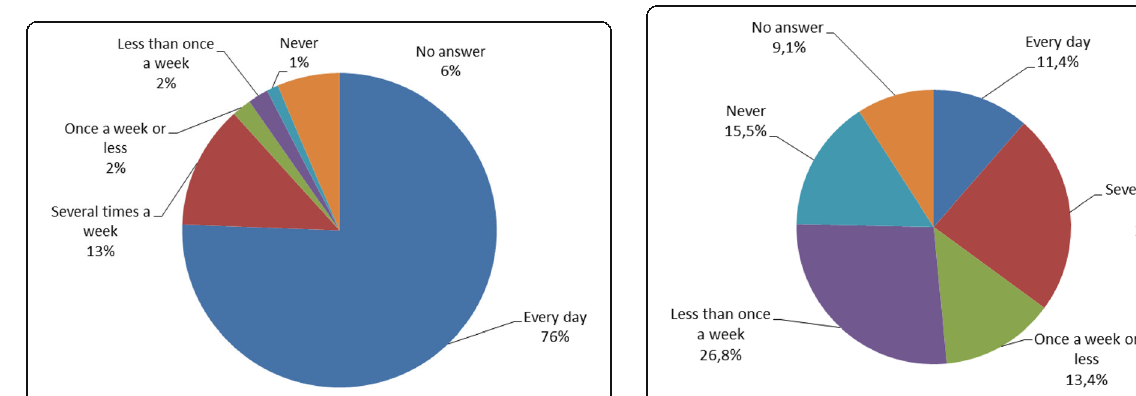
Fig. 7 The percentage division of children depending on the frequency of their consumption of brown